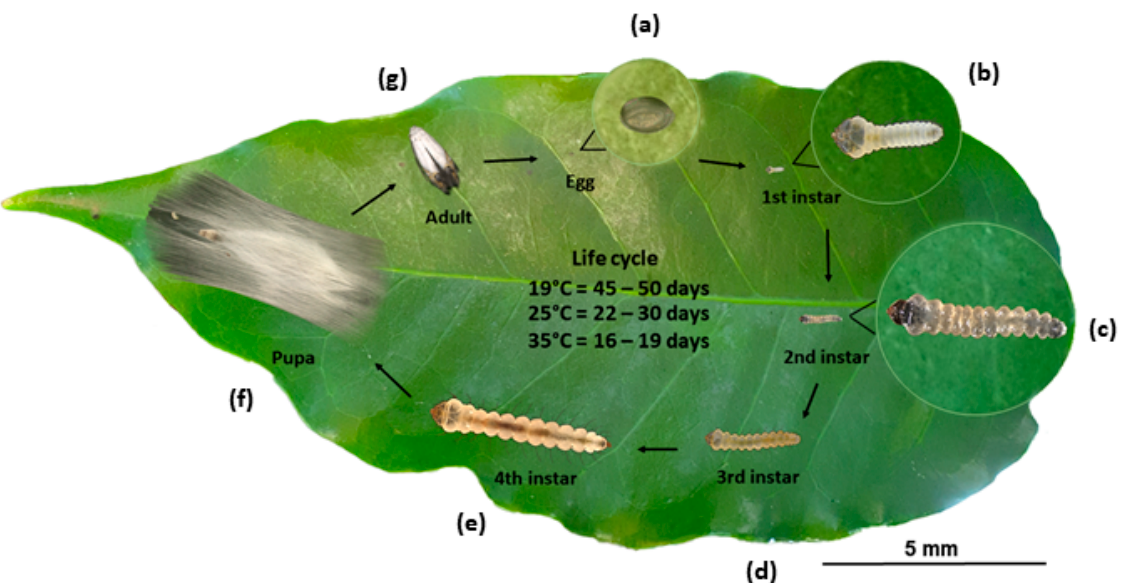
Figure 2. L. coffeella life stages from egg to adult. After hatching the egg, ( a ) the larvae development is divided into four instars: L1 ( b ), L2 ( c ), L3 ( d ), and L4 ( e ). The last instar forms a cocoon and turns into pupa ( f ). The adult emerges ( g ) from the pupa to mate. Eggs are laid over the adaxial side of the coffee leaf and the cycle restarts. Temperature rising accelerates and shortens the cycle span time, as detailed.